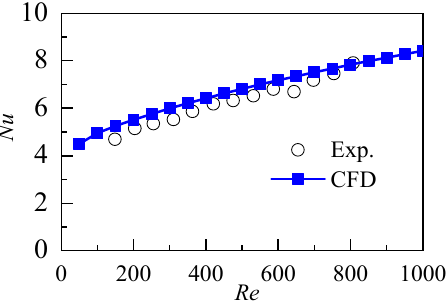
Figure 2. Model validation by comparing the present results with Lei et al. experiments [23].